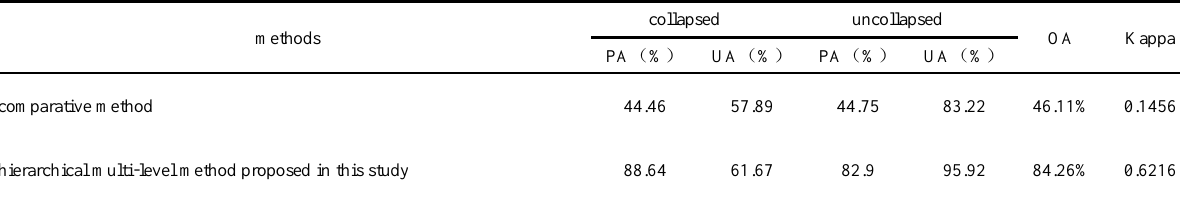
Table 2. Building collapse detection results by OCSVM using different methods